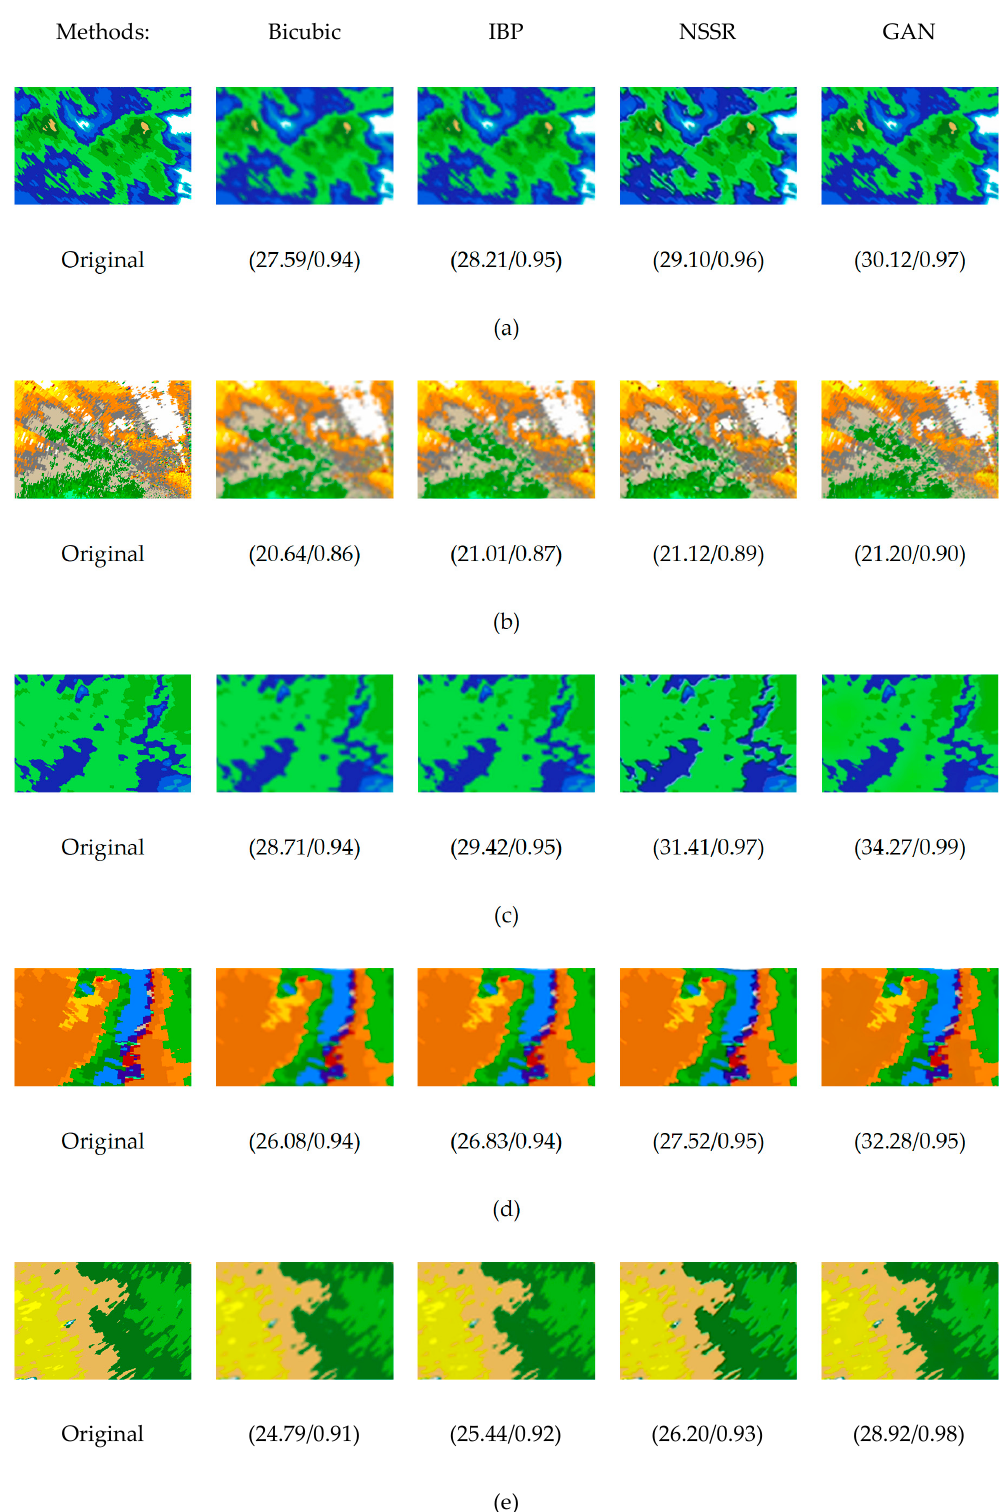
Figure 6. Qualitative reconstructed results of generative adversarial networks (GAN)-based methods and comparison with bicubic, iterative back-projection (IBP), and nonlocal self-similarity sparse representation (NSSR) using images from Figure 4 with upscale factors of × 4. Peak signal-to-noise ratio (PSNR) and structural similarity index (SSIM) results are shown below individual patch. GAN-based methods produces more crisp edges and details than other methods. ( a – e ) reconstructed result patch using image from Figure 4a–e ( ×